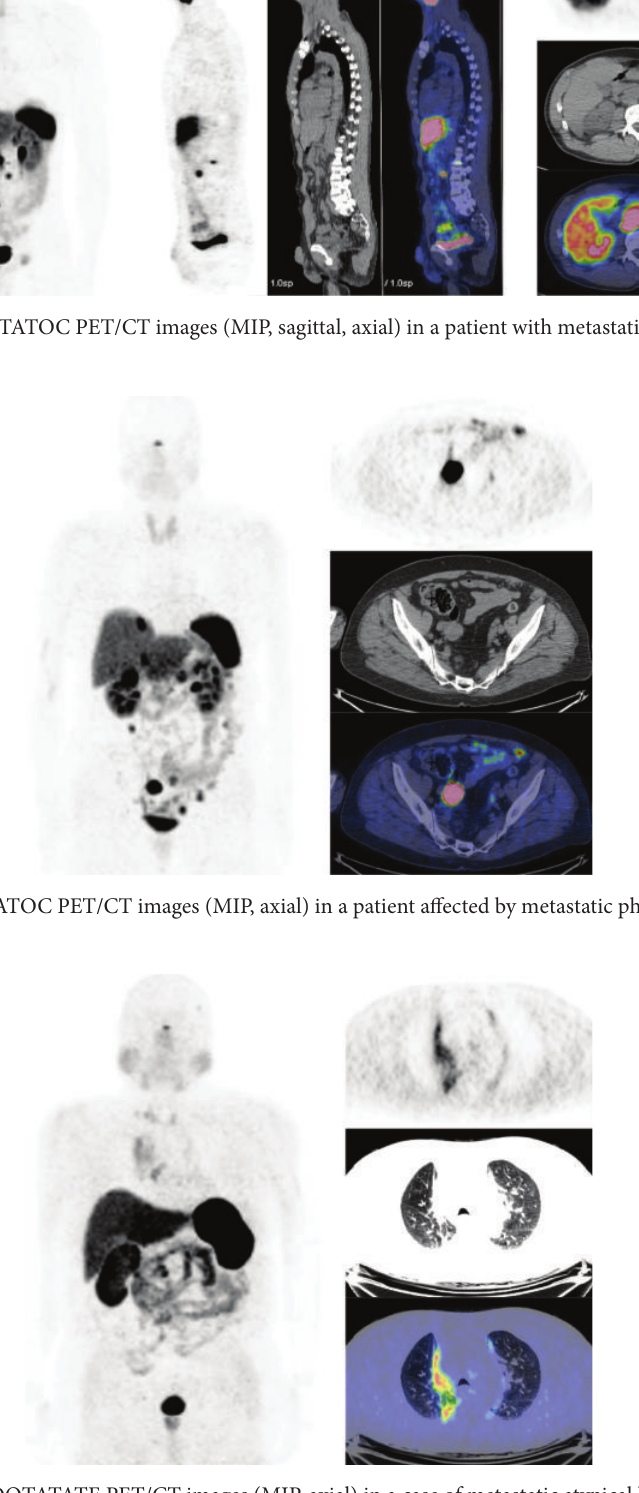
Figure 3: 68 Ga-DOTATATE PET/CT images (MIP, axial) in a case of metastatic atypical lung